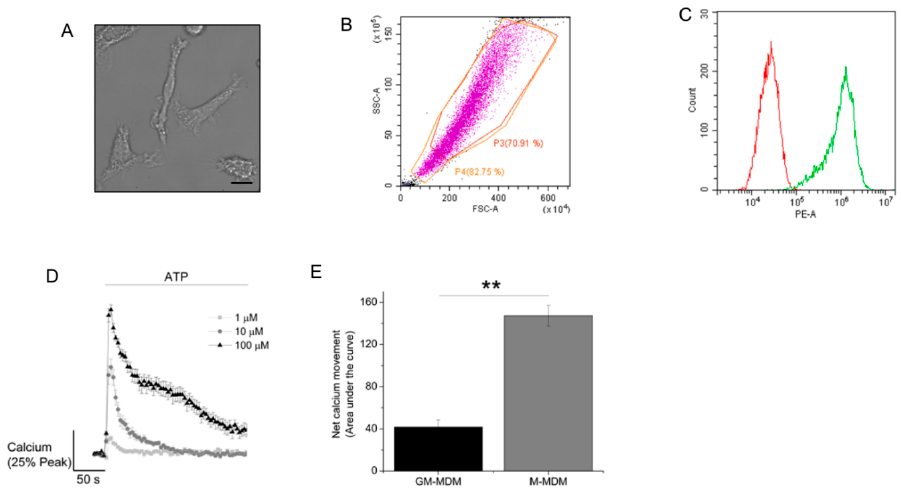
Figure 1. ATP evokes intracellular Ca 2 + responses in M-CSF di ff erentiated human macrophage. ( A ) Representative image showing macrophage di ff erentiated from monocytes by M-CSF treatment (10 ng / mL, 6 days). Scale bar is 10 µ M. ( B ) Flow cytometry forward and side scatter analysis. ( C ) Flow cytometry analysis of cell surface anti-CD14 immunoreactivity. Green channel for cells stained with anti-CD14 and red channel for antibody isotype control. ( D ) Averaged (3 donors) intracellular Ca 2 + responses evoked by ATP at di ff erent concentrations. ( E ) Comparison of the total Ca 2 + response evoked by 100 µ M ATP in GM-CSF (10 ng / mL, 6 days) versus M-CSF di ff erentiated macrophage (3 donors each). ** p < 0.01. All data is mean ± SEM; hypothesis testing by t